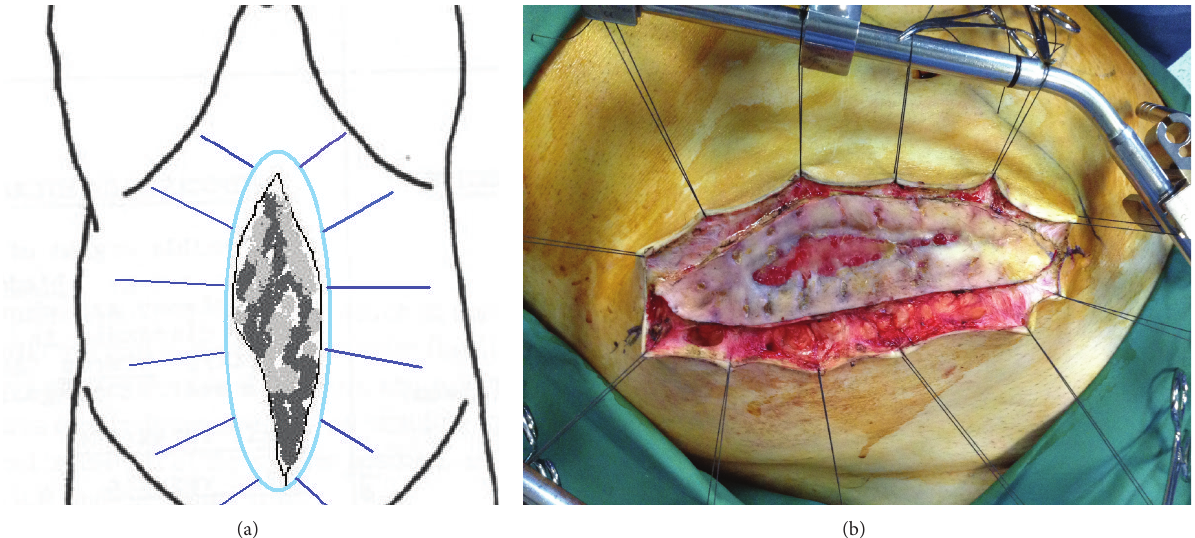
Figure 1: Elliptical incision, away from the granulating surface of the open abdominal